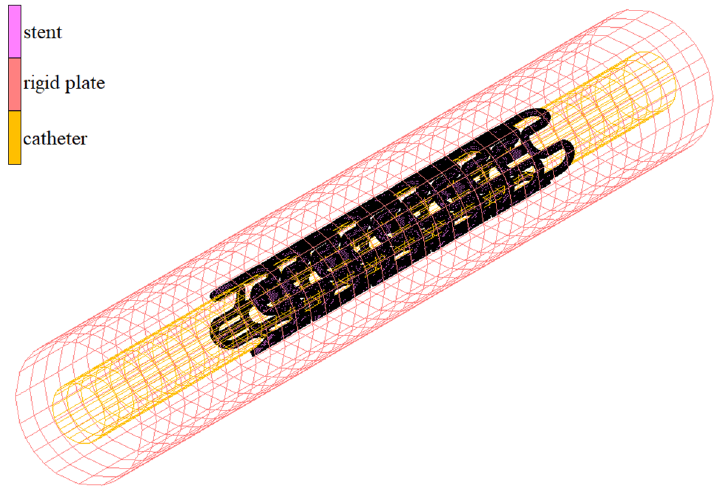
Figure 6. Numerical model for deployment simulation .